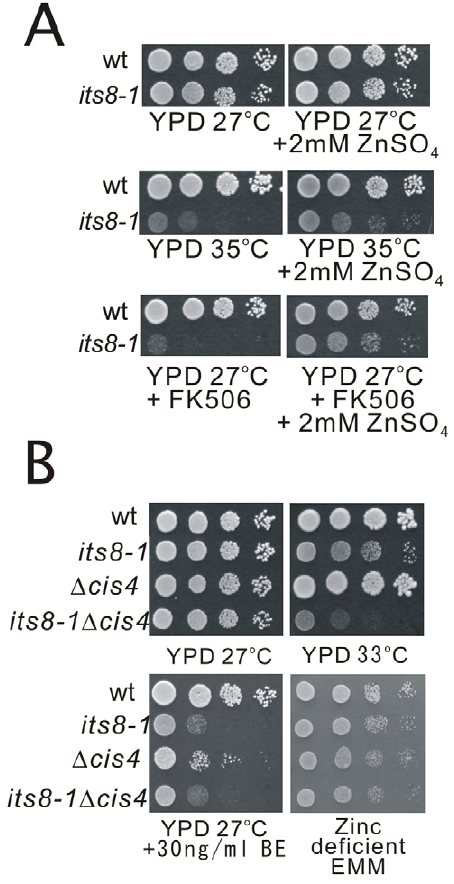
Figure 5. Genetic interaction between cis4 + and its8 + genes. (A) Effect of the addition of extracellular Zn 2 + on the phenotypes of its8-1 mutant. Wild-type or its8-1 mutant cells were spotted onto each plate as indicated and then incubated for 4 days at 27 u C or at 35 u C. (B) The its8-1 D cis4 double mutants showed more marked temperature sensitivity than the single mutants, while the double mutants showed similar BE49385A-sensitivity as compared with that of the its8-1 mutant. Wild-type, its8-1 , D cis4 , and its8-1 D cis4 cells were spotted onto each plate as indicated and then incubated for 4 days at 27 u C or at 33 u C. doi:10.1371/journal.pone.0041946.g005 Figure 4E, the fluorescence of GFP-Ecm33 in wild-type cells was enriched in the cell surface and the medial region in the zinc- deficient medium. In contrast, in D cis4 cells GFP-Ecm33 primarily localized to the intracellular dots and to the ER in the zinc- deficient medium (Figure 4E).